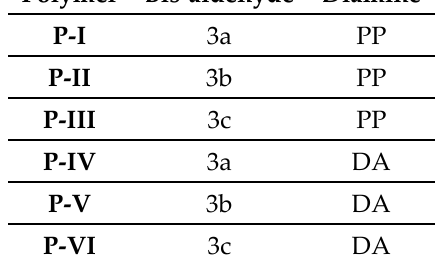
Figure 5. Synthetic scheme of polyazomethines from bis-aldehydes and diamines.